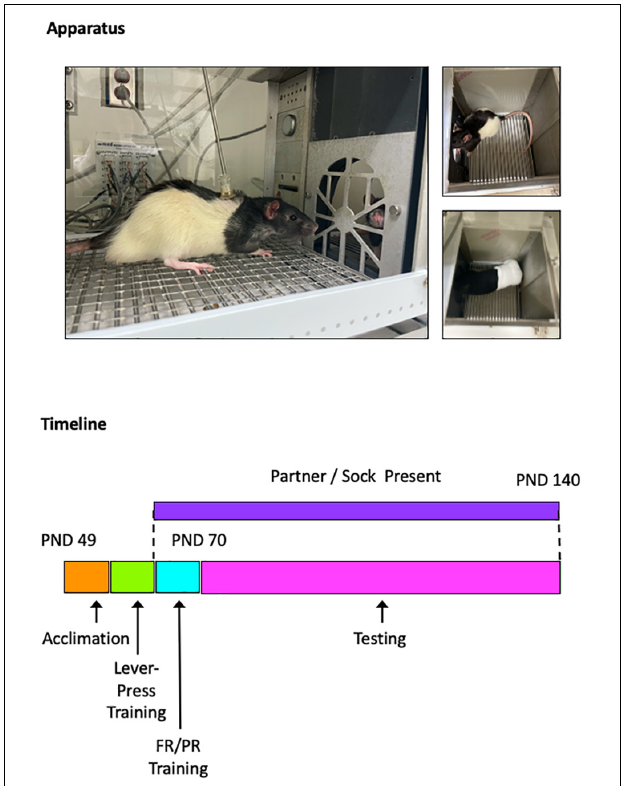
FIGURE 1 | Photographs of experimental apparatus (top) . Photographs show experimental subject interacting with a social partner (left) , overhead view of social partner (upper right) , and overhead view of non-social stimulus (sock; lower right ). Timeline of experimental events (bottom) . Rats were obtained on PND 49, testing began on PND 70, and testing ended on PND